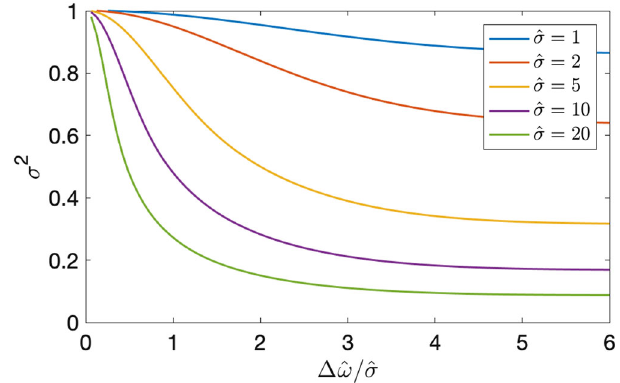
FIG. 1. Model of the averaged seeded output spectrum with uncorrelated broadband SASE pedestal. A 0 is the SASE intensity, A ˆ σ 1 the seed intensity, A 0 is the scaled rms SASE bandwidth, scaled rms seed bandwidth, and Δ ˆ ω is the window of integration.